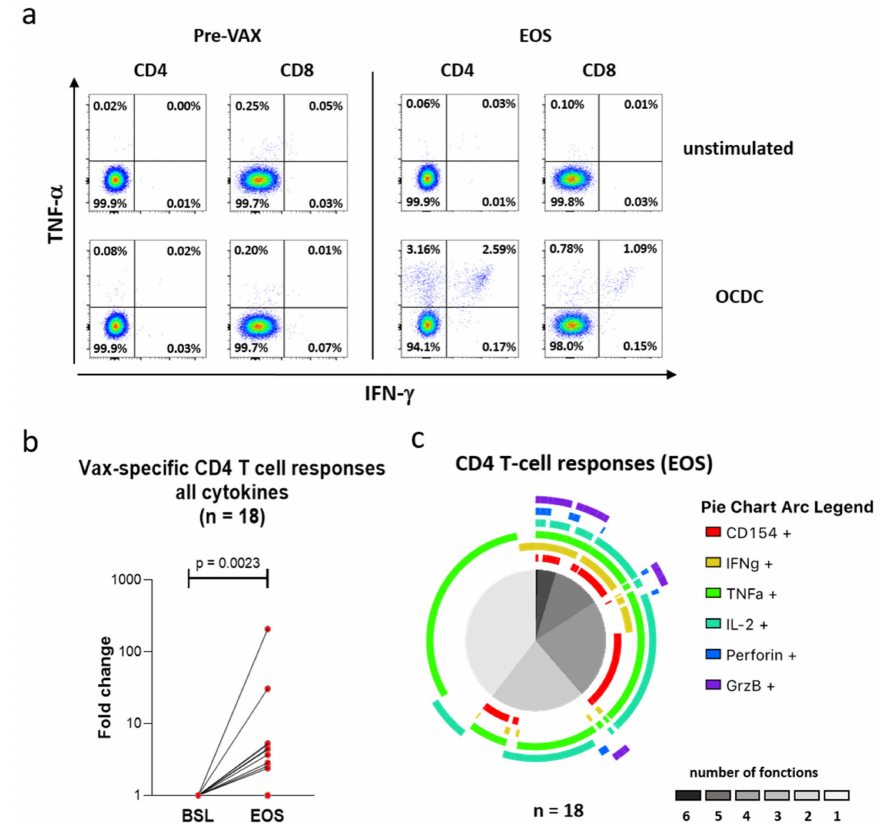
Figure 8. Patient vaccination with mo-DCs loaded with autologous Ox-L e ffi ciently induces polyfunctional (i.e., the production of at least two cytokines) tumor- and neoantigen-specific CD4 + T cell responses. ( a–c ) Peripheral blood mononuclear cells (PBMC) were isolated from ovarian cancer patients vaccinated with mo-DCs loaded with autologous Ox-L (OCDC) either prior (Pre VAX) or after vaccination (EOS) and incubated in vitro with OCDC. T cell phenotype and cytokine production were assessed by intracellular cytokine staining followed by flow cytometry analysis (ICS). For the details of the vaccination schedule we refer to our previous publication